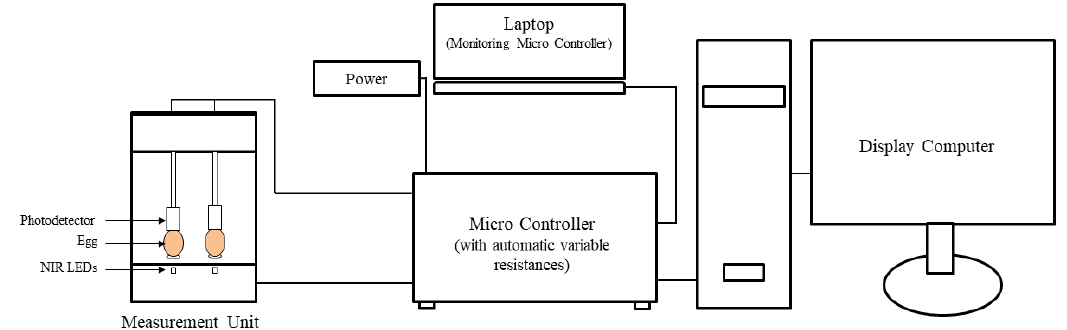
Figure 1. Schematic diagram of near-infrared sensor and signal acquisition system of incubated eggs.